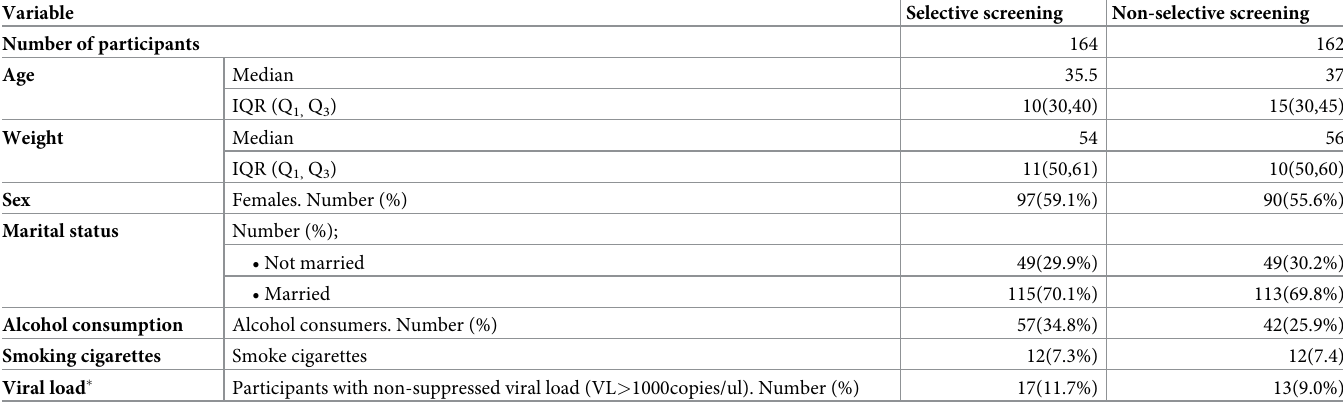
Table 1. Baseline socio-demographic and clinical characteristics of 326 participants at Princess Diana Memorial Health Centre IV, Soroti District, April to June 2018.